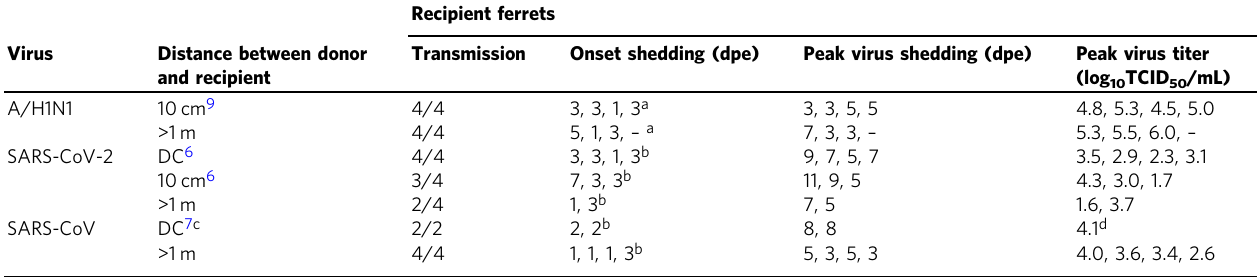
Table 1 Virus transmission to recipient ferrets over various distances.